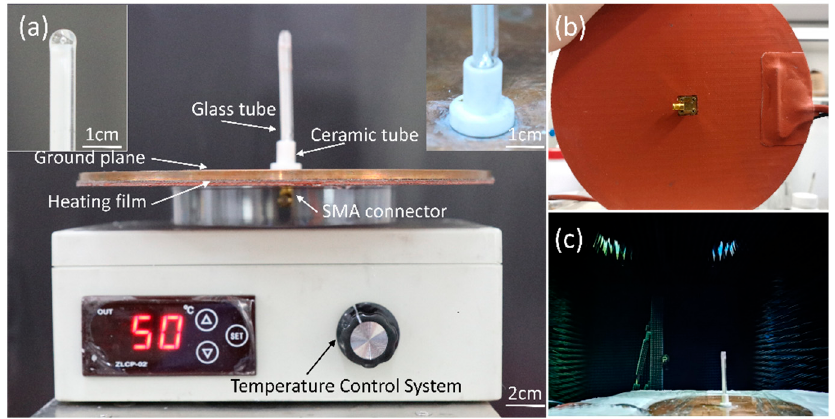
Figure 4. Fabricated antenna prototype. ( a ) Front view. The left illustration is the enlarged view of the top of the glass tube. The right illustration is the enlarged view of the bottom of the glass tube. ( b ) Bottom view. ( c ) Measurement setup of the liquid metal reconfigurable antenna in an anechoic chamber.